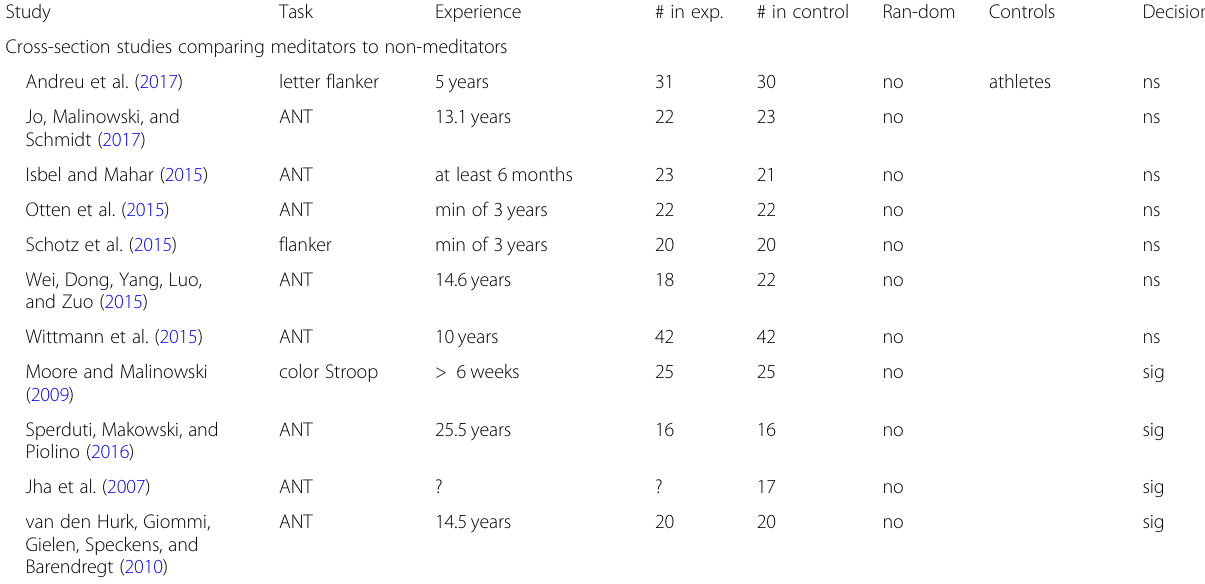
Table 1 Results of studies testing for benefits of mindfulnessmeditation on interference control (Continued) Study